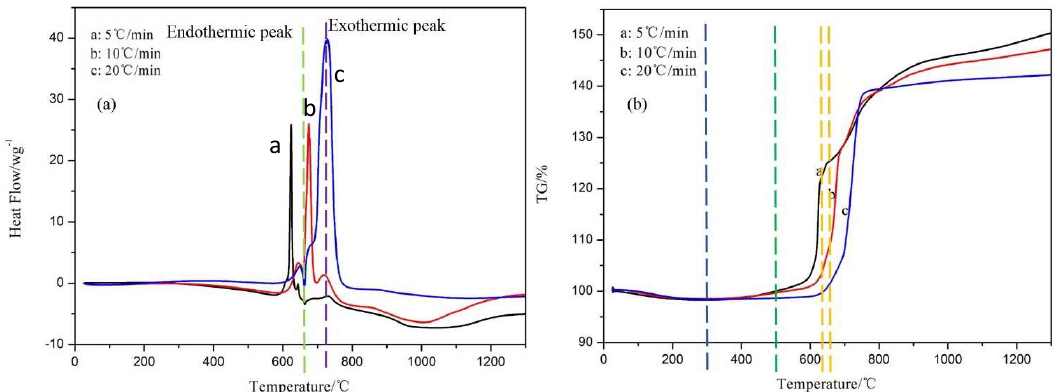
Figure 6. Differential scanning calorimetry—thermogravimetry (DSC-TG) curves for aluminum nanoparticles at different heating rates (i.e., 5, 10, 20 °C·min −1 ). ( a ) Differential scanning calorimetry (DSC), ( b ) Thermogravimetry (TG) curves. The peak characterization and thermal stages are marked with dot line with different colors.